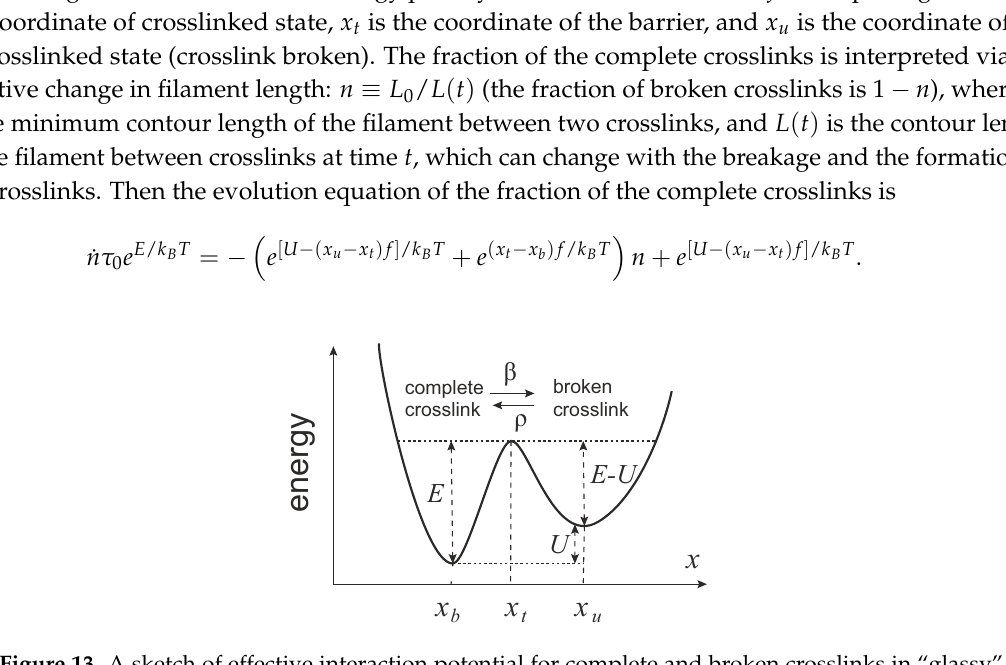
Figure 13. A sketch of effective interaction potential for complete and broken crosslinks in “glassy” filament network